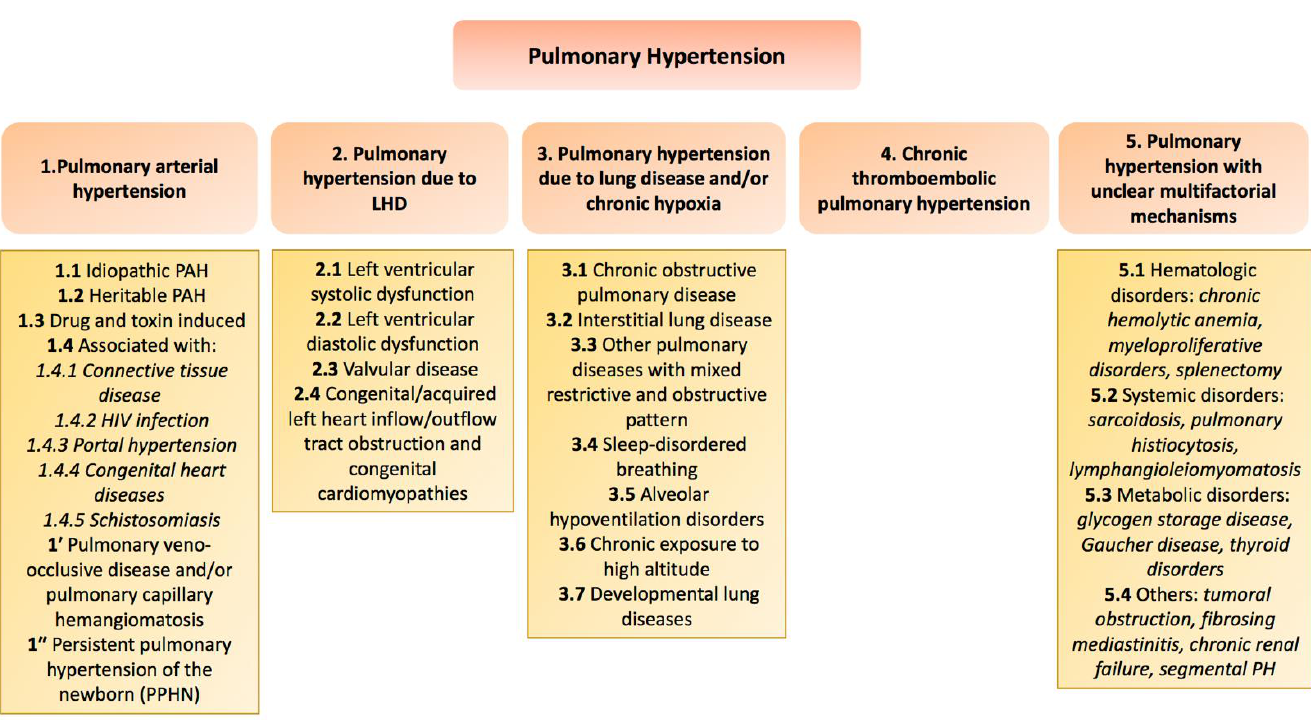
Figure 1. Latest classification of pulmonary hypertension (HIV: human immunodeficiency virus; LHD: Left-heart disease